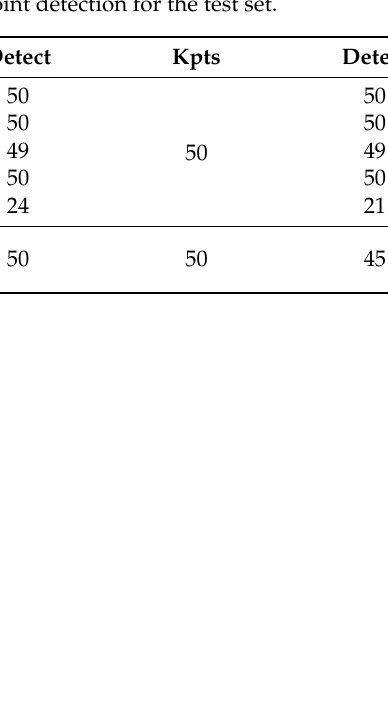
Figure 19. A wrong detection result obtained by Keypoint-RCNN.